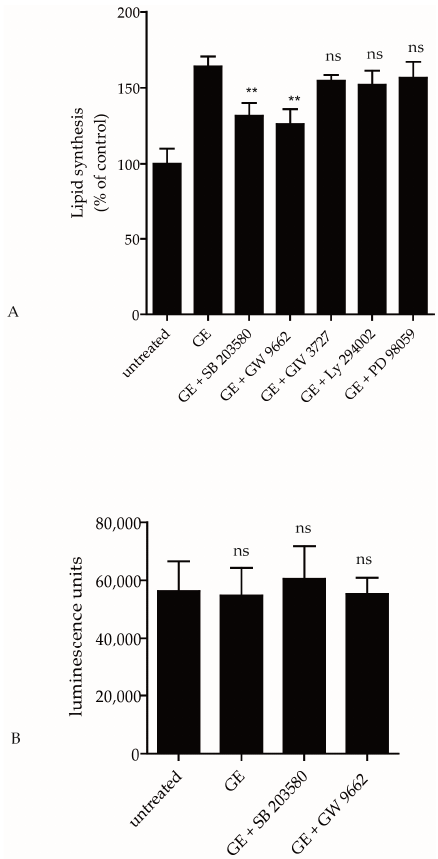
Figure 4. GE-induced lipid synthesis involves the MAPK and PPAR pathway. hPKs were cultured in 96 well plates and were treated with vehicle, GE (200 µg/mL), or with GE and one of the inhibitors (p38 MAPK inhibitor SB203580, PPAR γ antagonist GW9962; NF κ B inhibitor GIV 3727, phosphatidyl-inositol-3-kinase inhibitor LY294002 or ERK inhibitor PD98059) for 6 days. ( A ) Quantitative measurement of intracellular neutral lipids as assessed after Nile Red labeling and ( B ) measurement of cell viability as was assessed with the ViaLight Plus bioassay kit. All Data are expressed as means ± SD of 6 independent experiments with 8 replicates respectively (ns—not significant, ** p < 0.01).